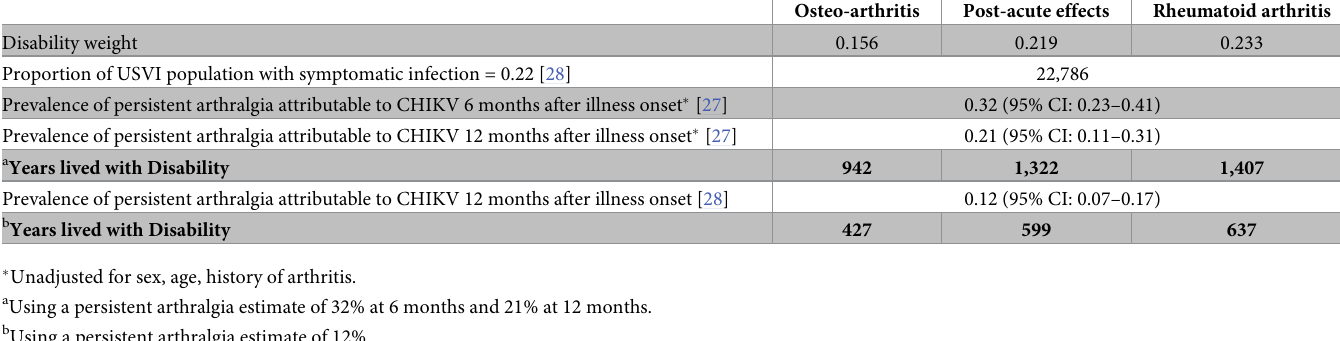
Table 5. Years lived with disability due to persistent arthralgia following the chikungunya outbreak, (total U.S. Virgin Islands population =